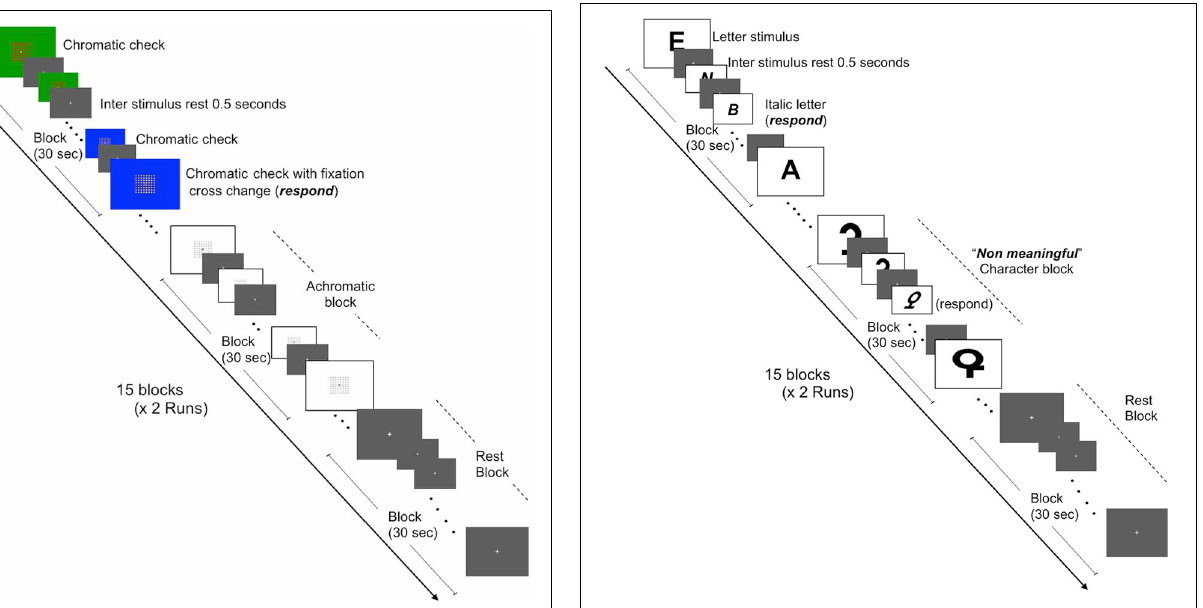
FIGURE 1 | Schematic representation of fMRI task for brain activation in response to chromatic check patterns and color localization. Representations of the three conditions (chromatic, achromatic, and rest states) are depicted. Two runs (7min and 30s each) containing 15 blocks (30s in duration) and consisting of equal amounts of each condition, i.e., five blocks of each condition per run were constructed.